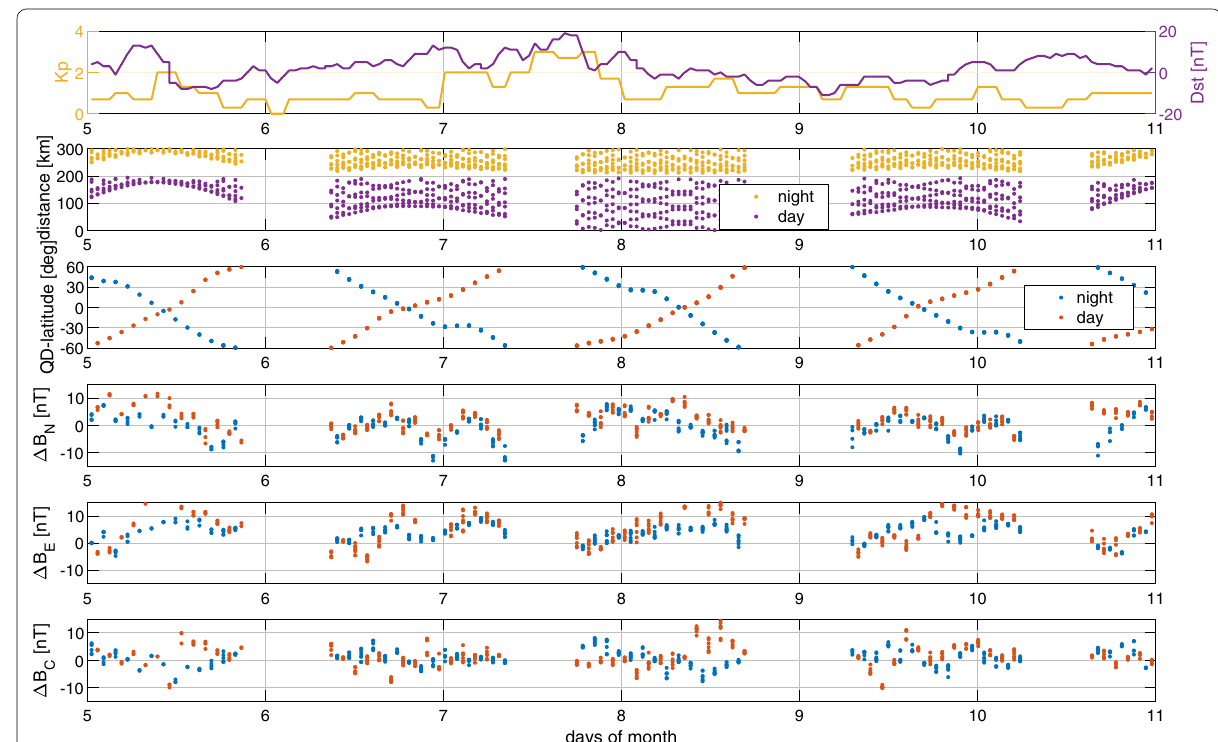
Fig. 7 Close conjunctions between the CryoSat‑2 and Swarm Bravo satellites in August 2018. From top to bottom: geomagnetic activity indices Kp and Dst ; inter‑satellite distances; QD‑latitude of conjunctions; the three components of the magnetic field difference (cid:31) B